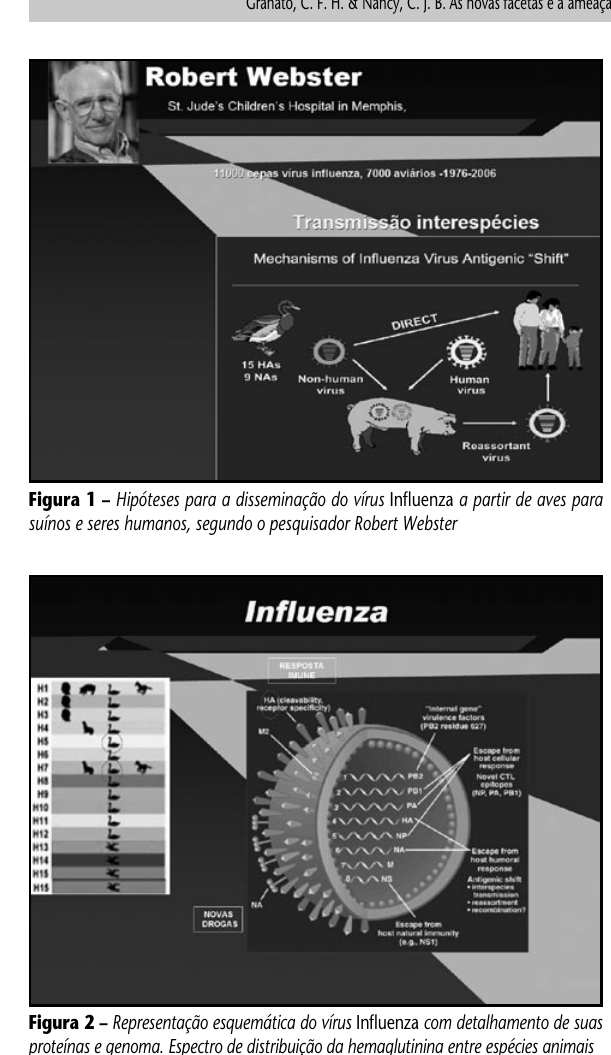
Para nós, profissionais de laboratório, é preocupante ainda a questão do diagnóstico etiológico dessas